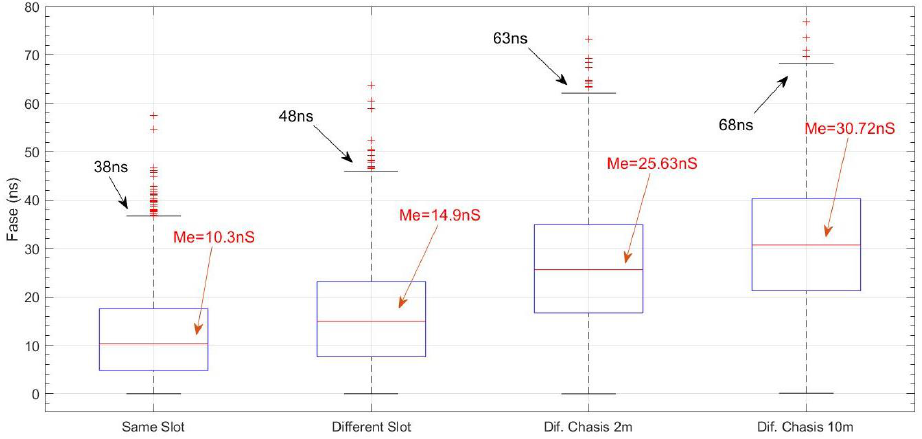
Figure 12. Box-and-whisker plot for SAR converter tests.